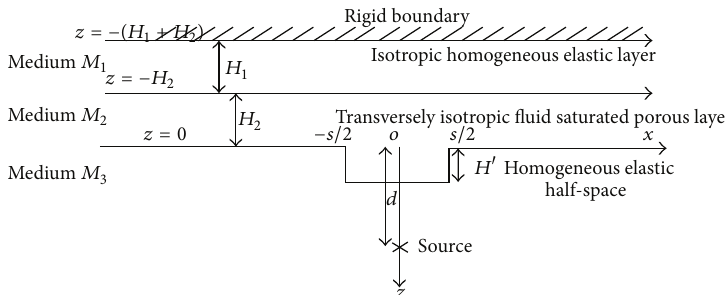
Figure 1: Geometry of the